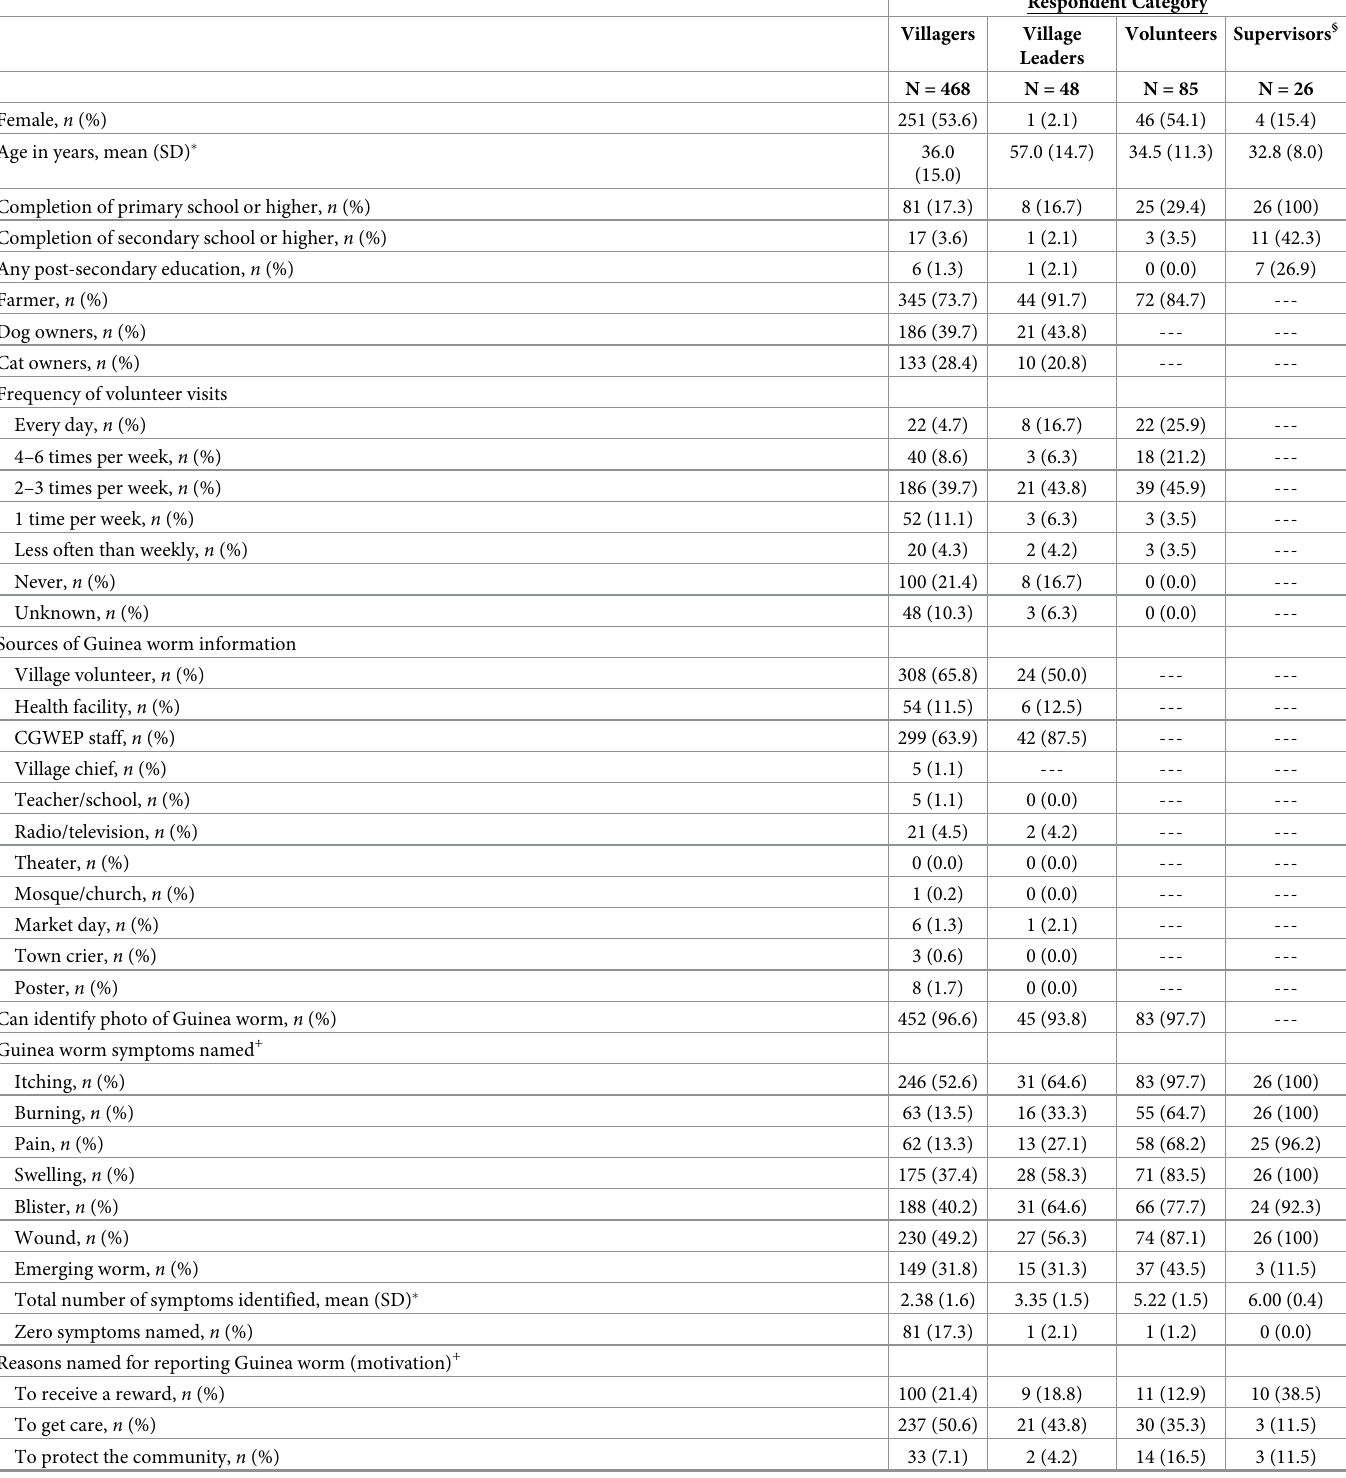
Table 1. Descriptive statistics by respondent category for the survey to evaluate the Chad Guinea Worm Eradication Program active surveillance system: September